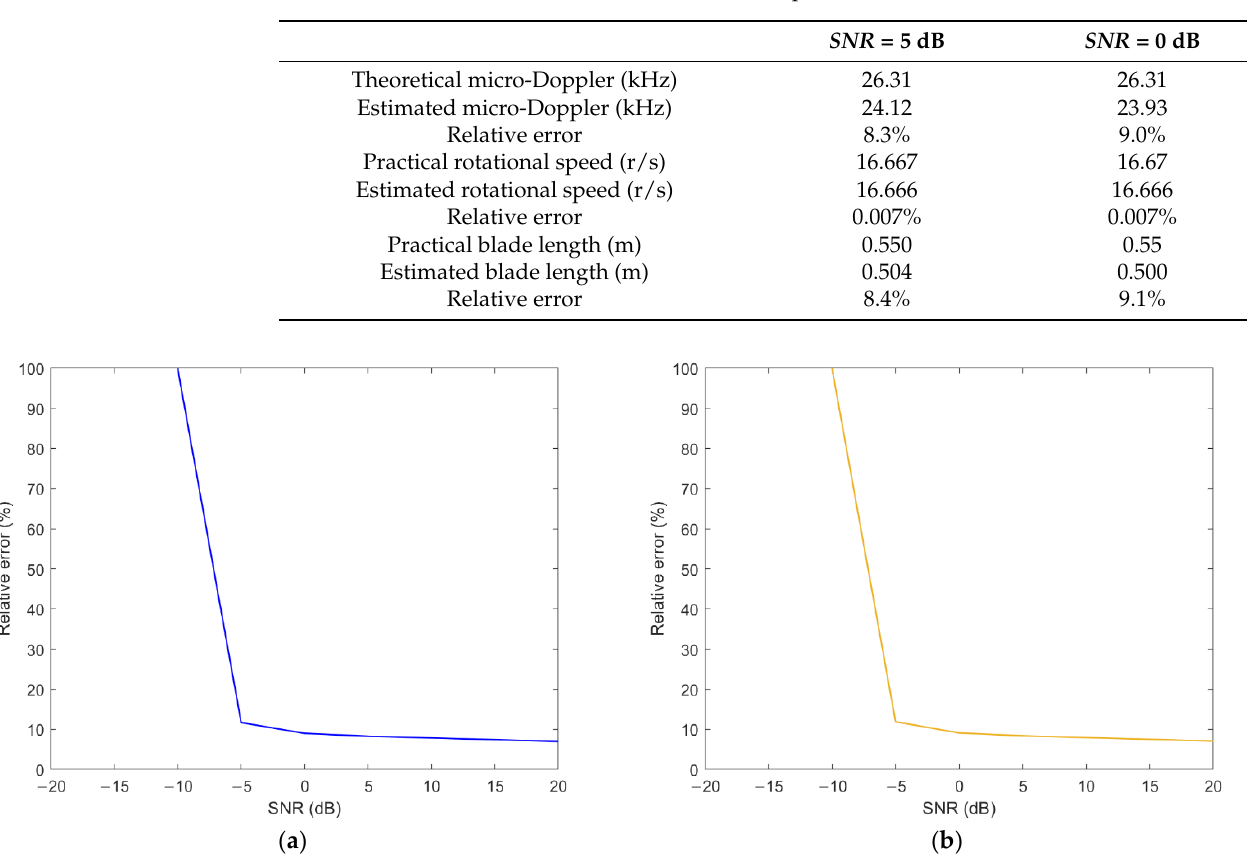
Table 3. Estimation results of turbine micro-motion parameters.